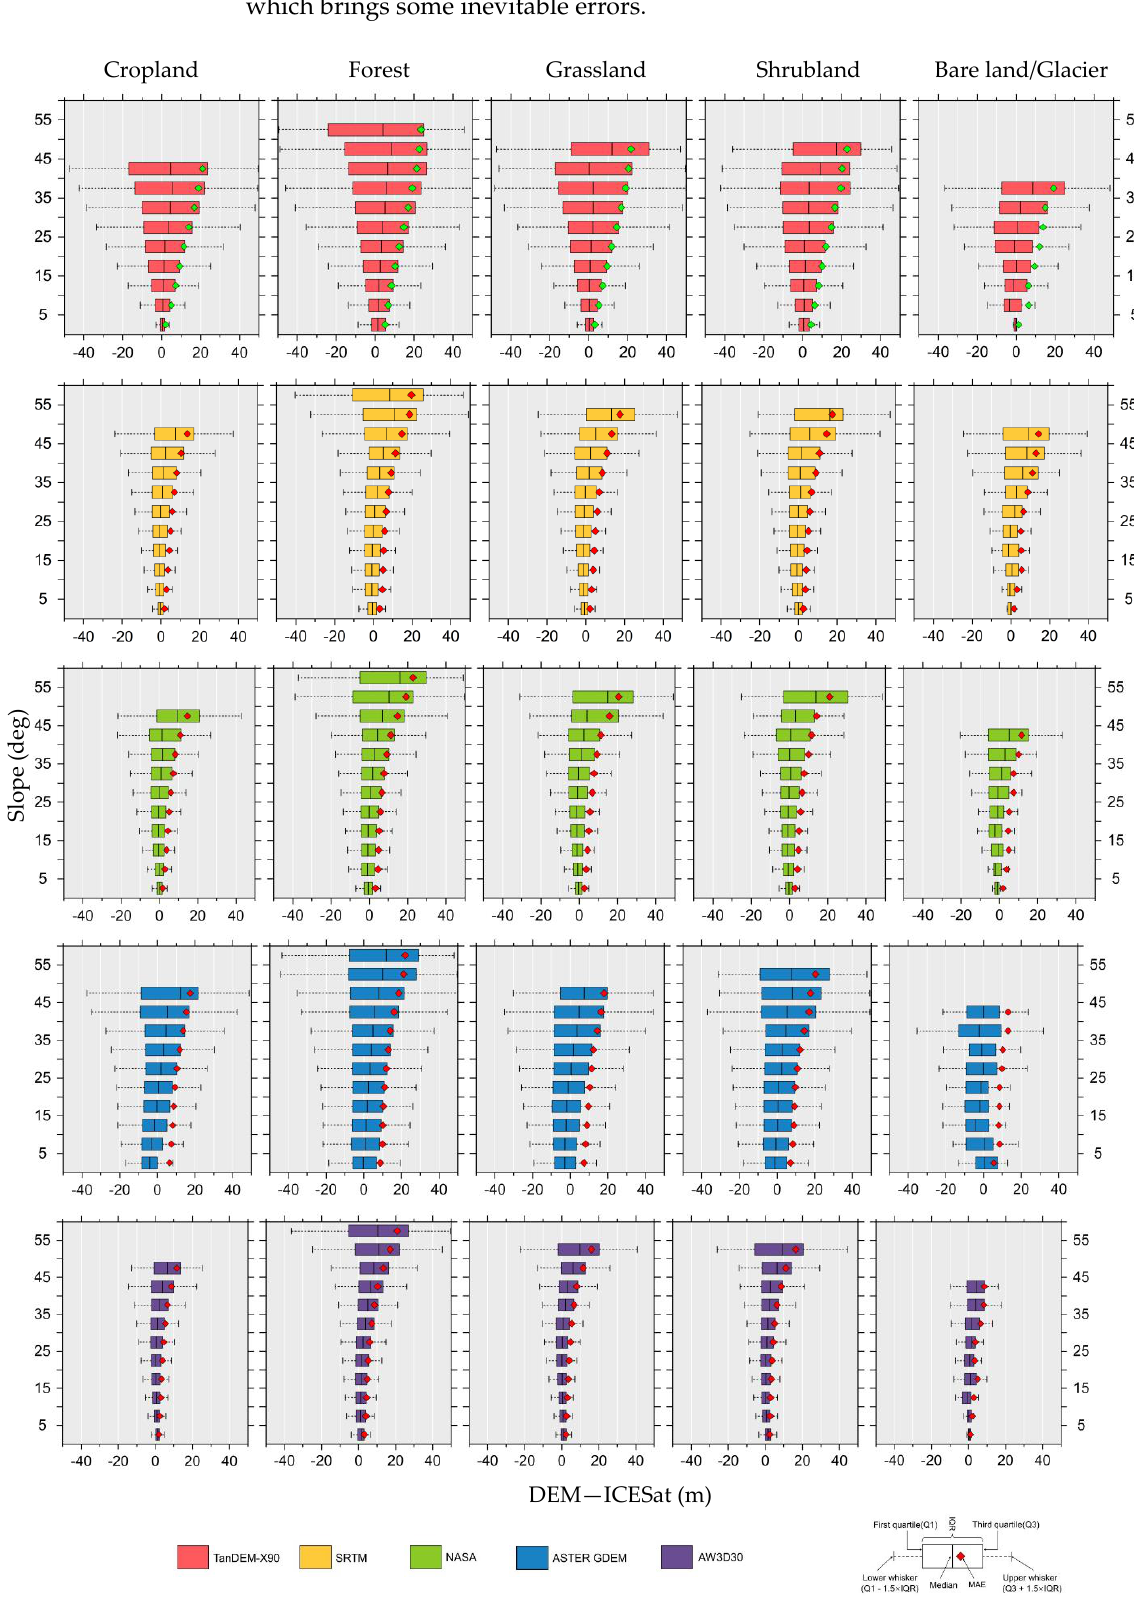
Figure 13. Slope-grouped boxplots of differences (i.e., bias) according to landcover